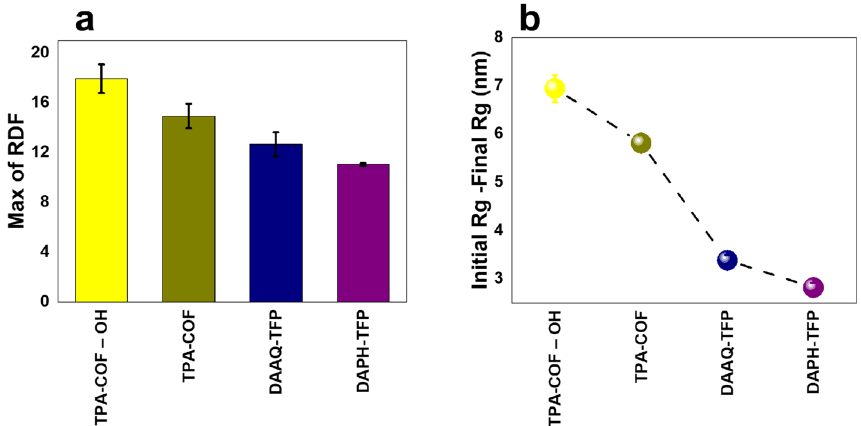
Figure 5. ( a ) The difference of initial and final gyration radius ( b ) The maximum of RDF values for each nanoparticle.